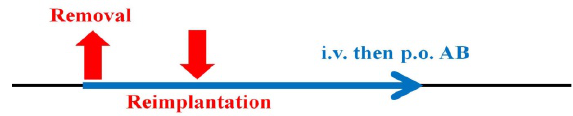
Figure 1. Two-stage exchange. (Adapted from [1])